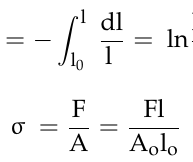
Figure 1. Heating cycles used for hot compression tests.